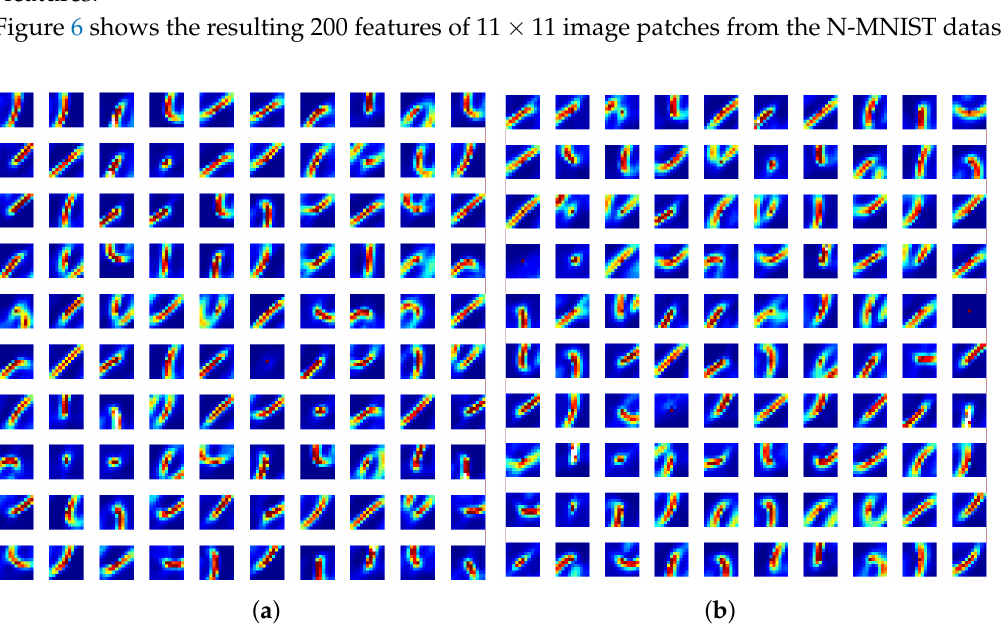
Figure 6. 11 × 11 features learned from the ON events (a) and off events (b) of the N-MNIST dataset. Each feature represents a normalized vector reshaped to match the size of the incoming feature